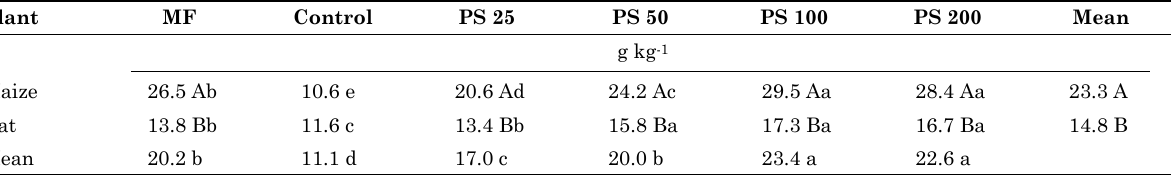
Mean values followed by different letters (lowercase letters in the row and uppercase letters in the column) differ by the Duncan test (p ≤